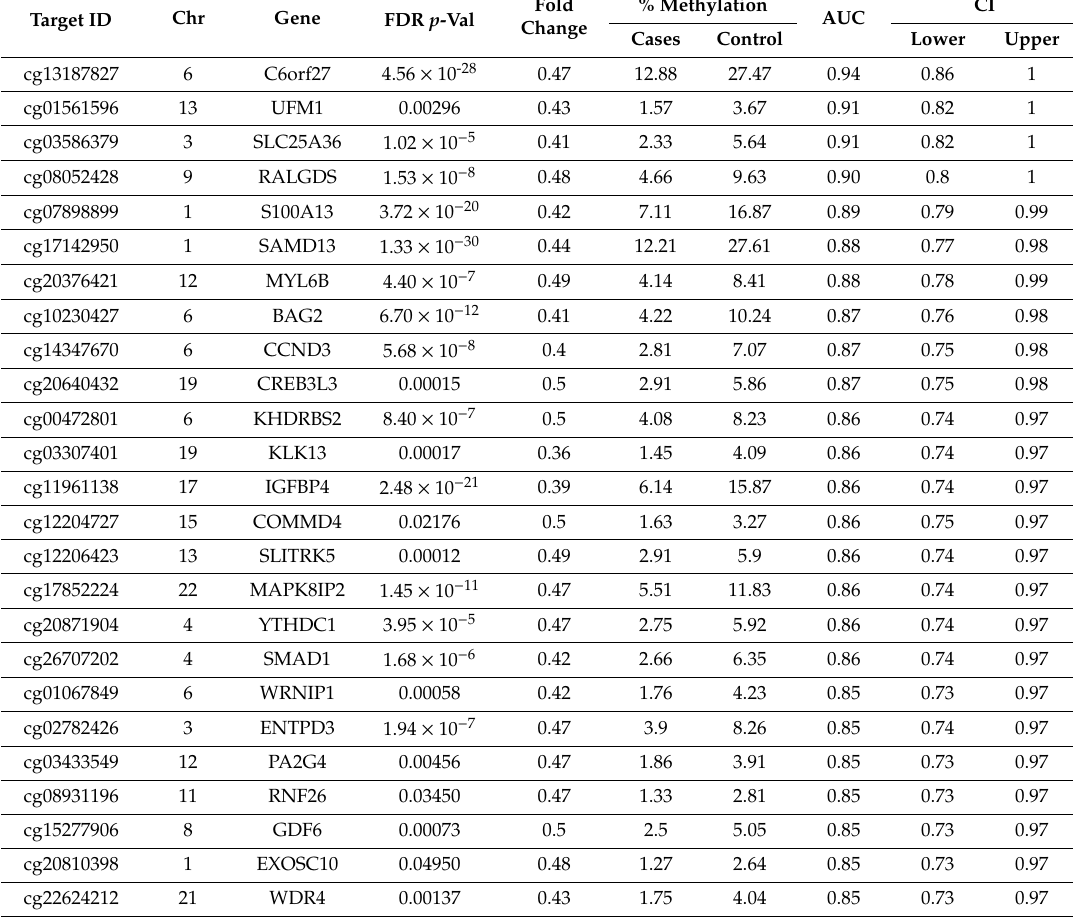
Table 1. Details of top 25 CpG targets significantly di ff erentially-methylated in CP based on AUC. Target ID, Gene ID, chromosome location,% methylation change, and FDR p -value are